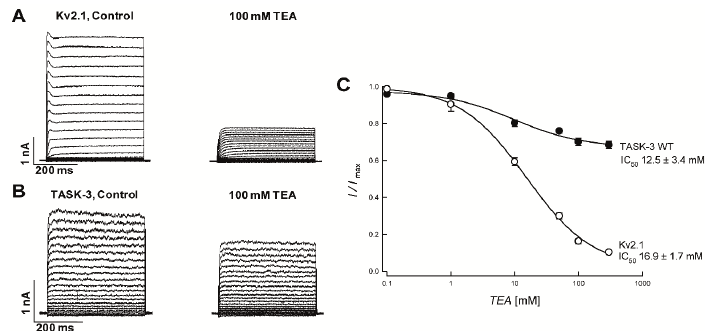
Figure 1 . Effect of TEA on Kv2.1 and TASK-3 channels expressed in HEK-293 cells. ( A ) Rat Kv2.1 channel currents measured with a voltage protocol (400-ms steps from − 100 mV to 100 mV with an increment of 10 mV and a holding potential of − 80 mV) before (left) and after (right) the exposition to 100 mM of TEA. ( B ) Application of 100 mM of TEA on TASK-3 channels, before (left) and after (right) the treatment. ( C ) Dose-response relationship of TEA on Kv2.1 and TASK-3 channel. TEA blockade was analyzed at +80 mV test pulse. Kv2.1 IC 50 value was 16.9 ± 1.7 mM ( n = 4).